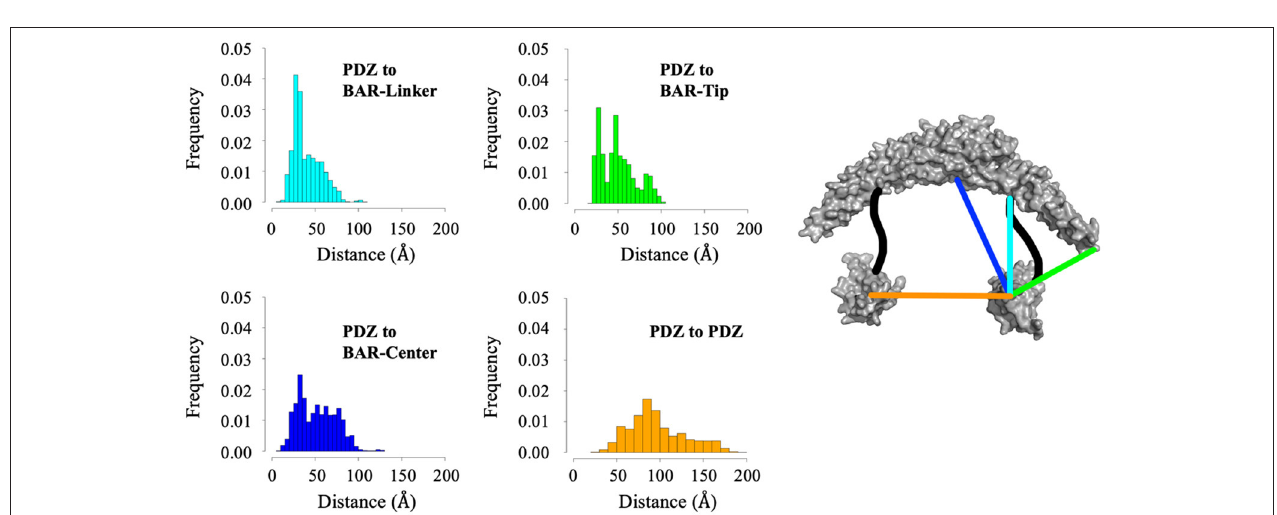
FIGURE 7 | Distance analysis between the PDZ domain and the BAR domain. Distance between the PDZ domain and the BAR-Linker was defined by residues L60 and S130. Distance between the PDZ domain and the BAR-tip was defined by residues L60 and S262. Distance between the PDZ domain the BAR-Center was defined by residues L60 and T167. Distance between the two PDZ domains was defined by residues L60 and